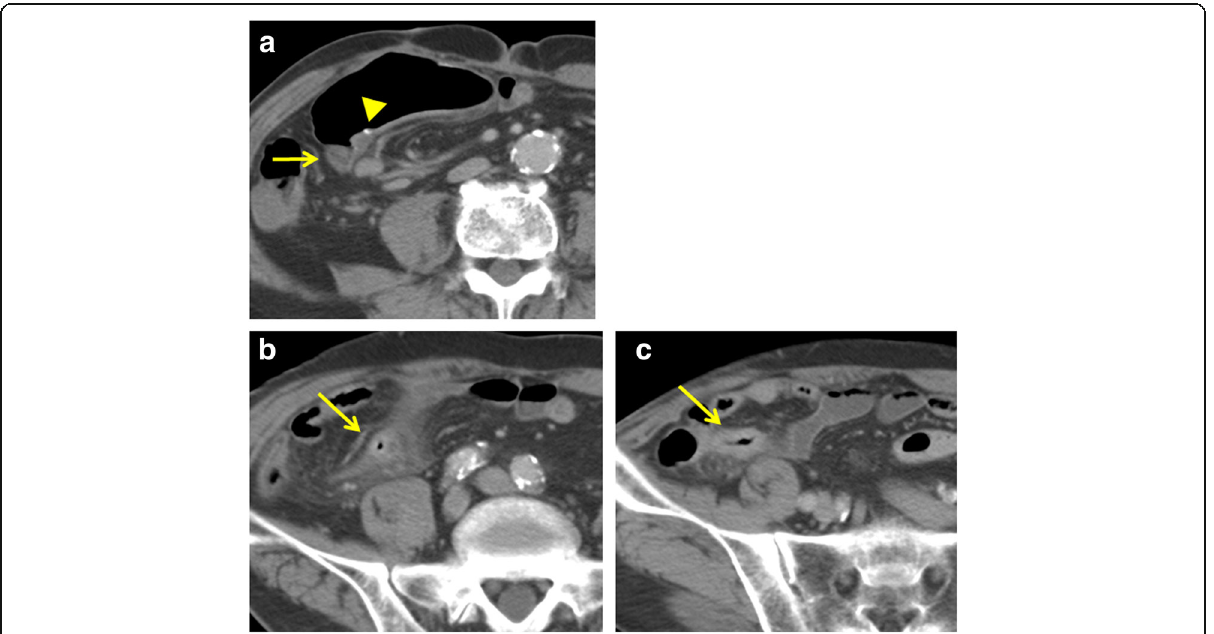
Fig. 1 a Computed tomography (CT) scan of the small intestine, revealing diameter change on the distal side of the anastomotic site (arrow). The triangle indicates a staple of the functional end-to-end anastomosis. b , c Wall thickening and inflammation of the mesentery were observed at the stenotic site